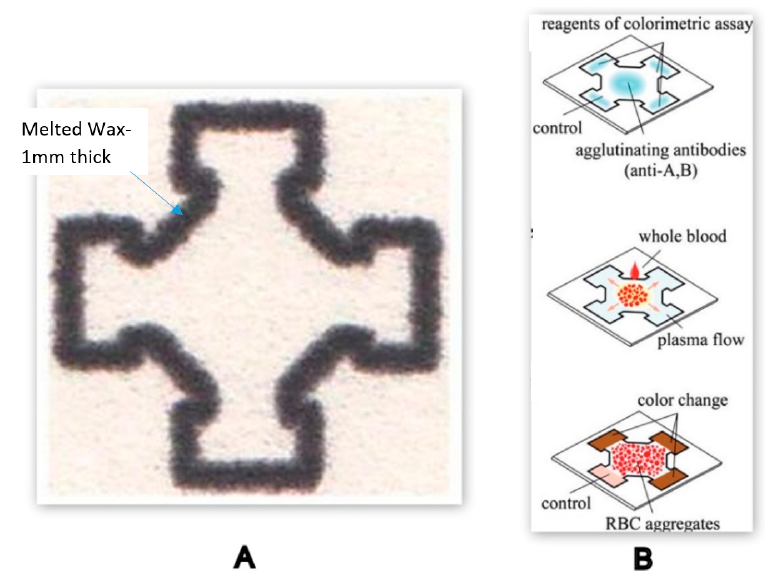
Figure 14. ( A ) Solid wax-printed microfluidic chip for separation of plasma from whole blood. ( B ) Schematic representation of a working µPAD. Taken with permission from [128].